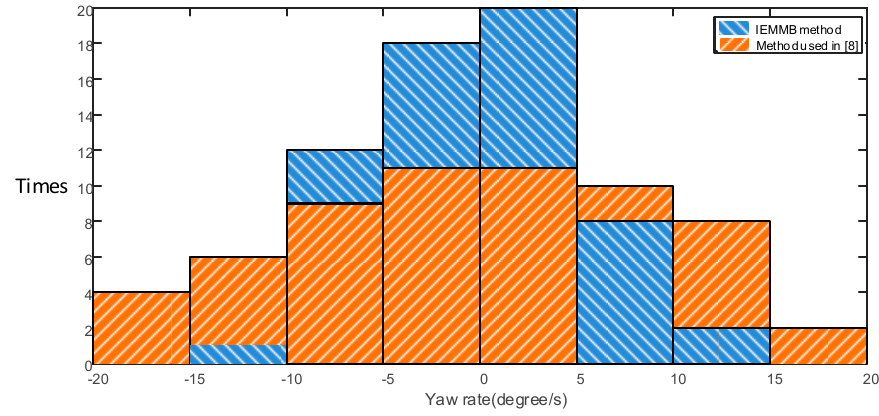
Figure 15. Maximum yaw rate during collision avoidance.